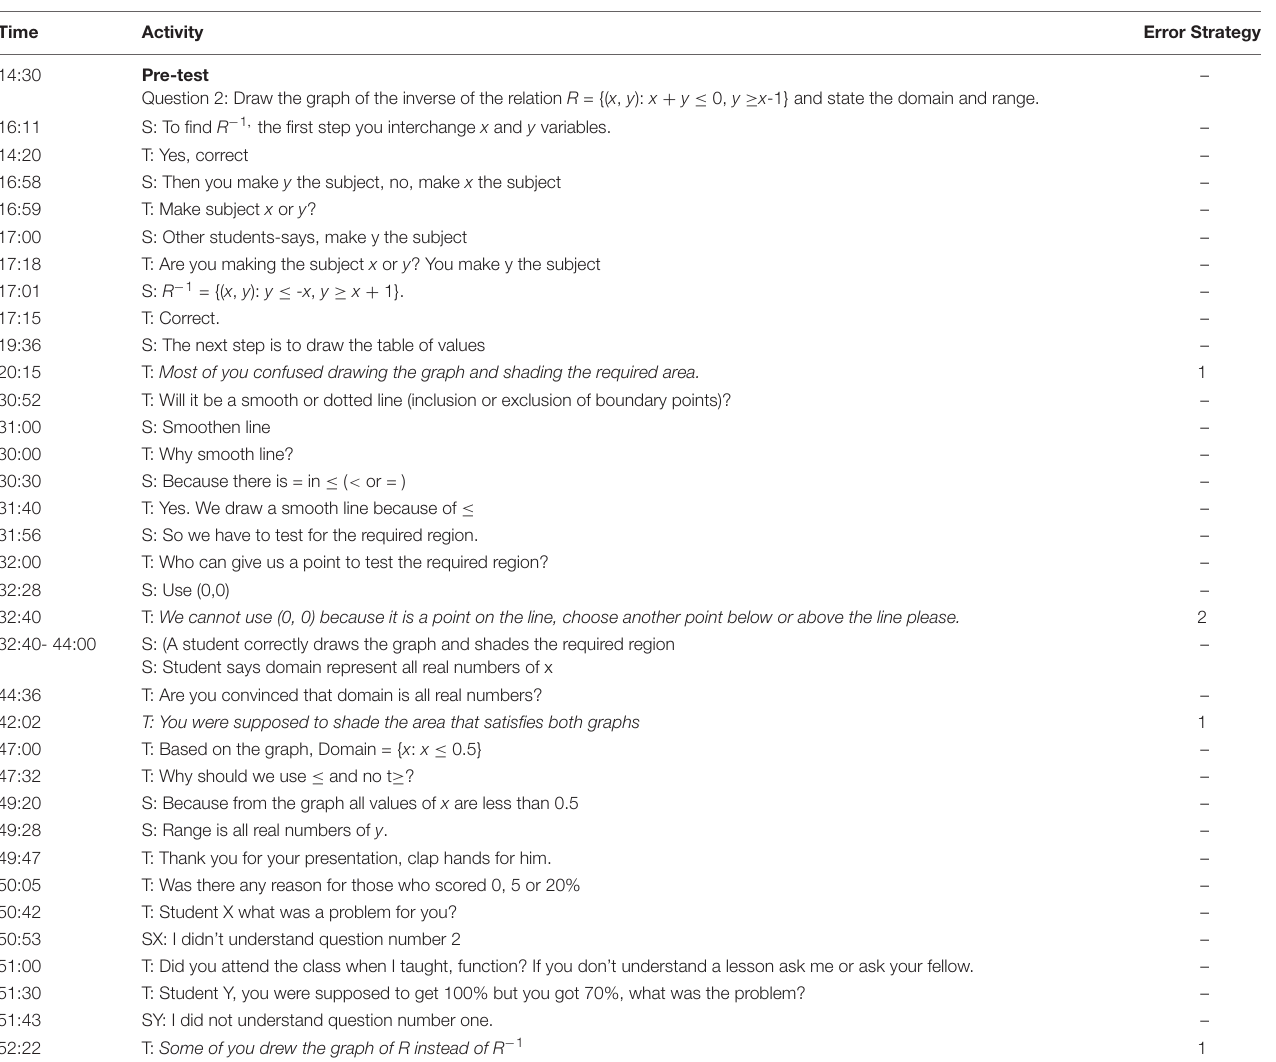
TABLE 6 | Examples of error handling strategies by Teacher 7 in the control condition at the pre-test. Time Activity Error